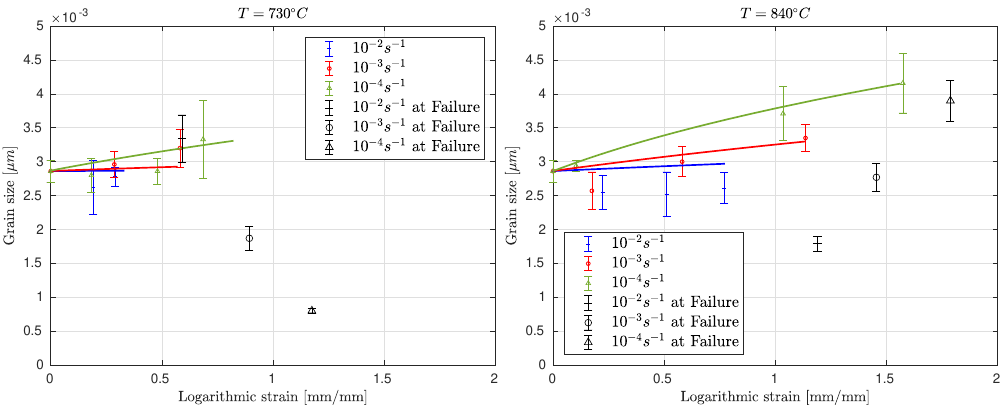
Figure 8. Grain size evolution at 730 ◦ C and 840 ◦ C for several strain rate conditions (Model predictions: lines; Experiment: Symbols).